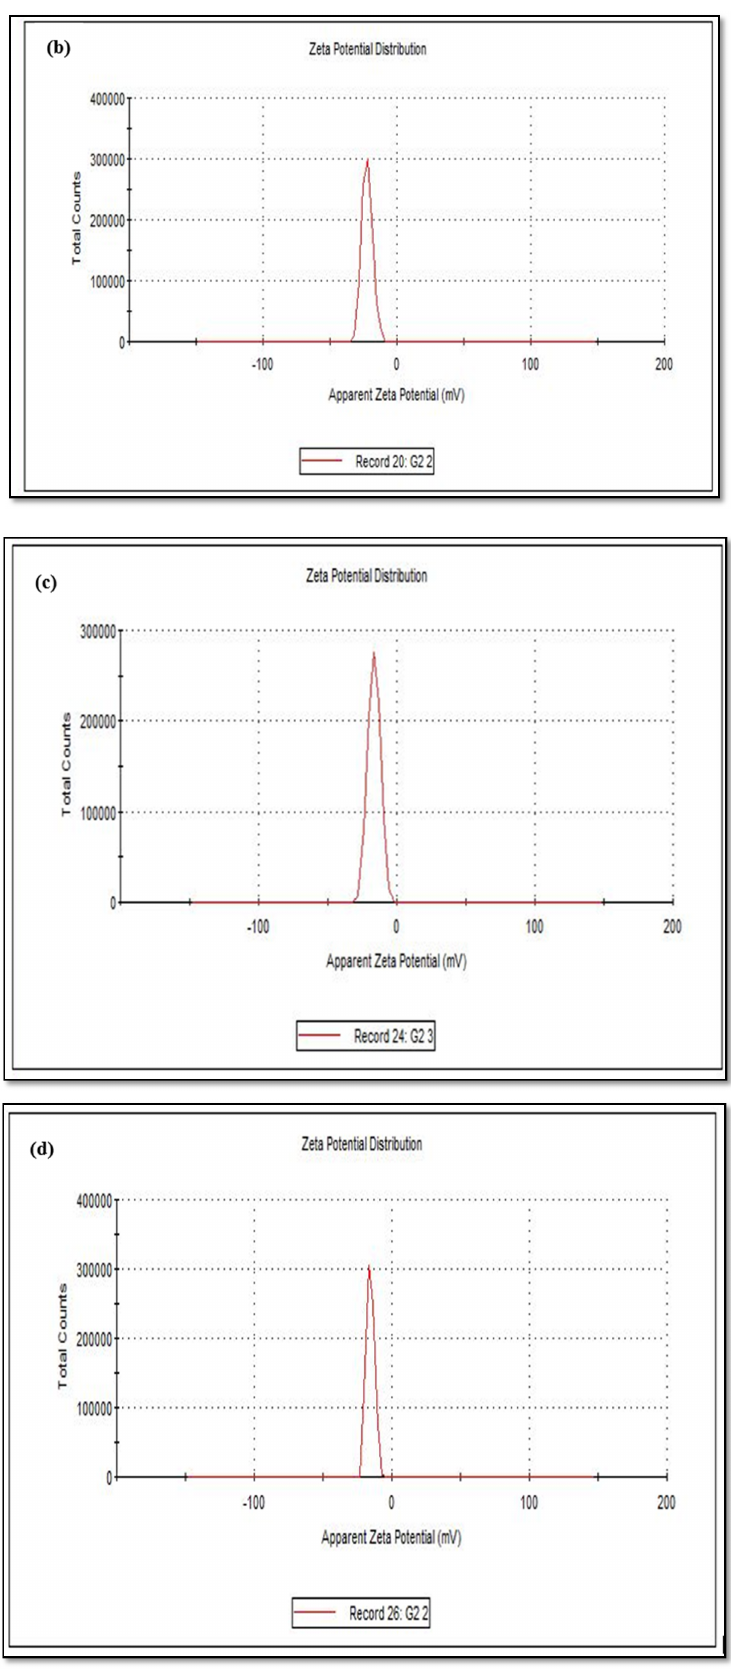
Figure 6. Zeta potential of ( a ) cCuO, ( b ) wCuO, ( c ) aCuO and ( d ) eCuO.